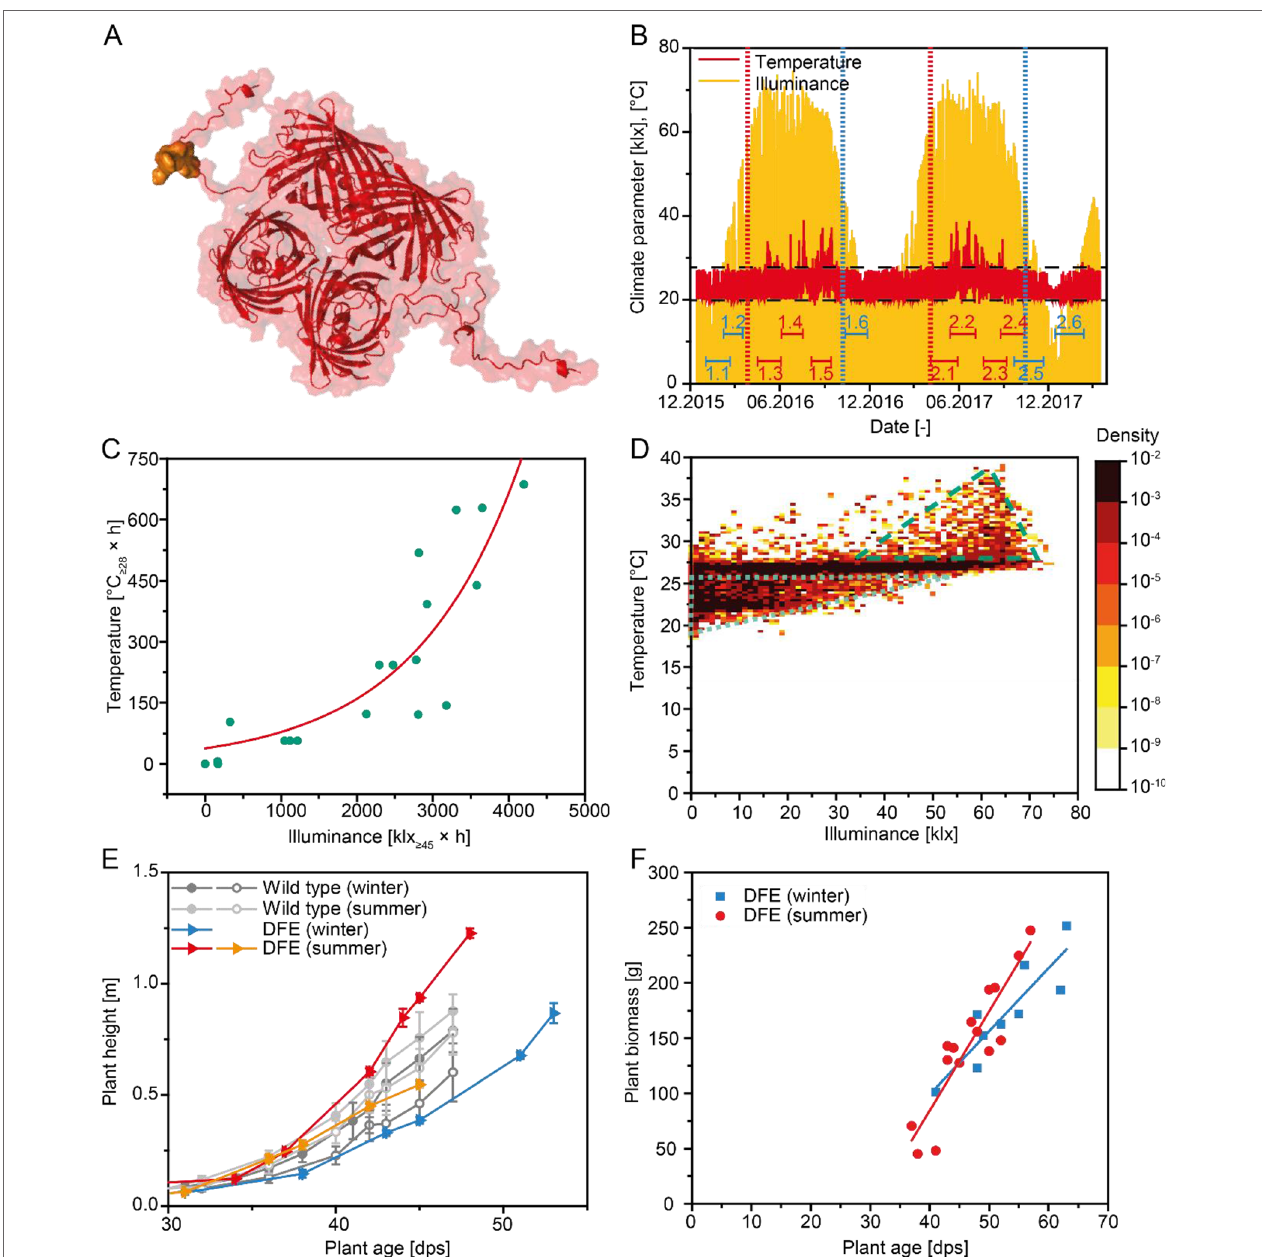
FIGURE 1 | Climate data and plant growth during the production of DFE. (A) Three-dimensional structure of a DFE tetramer. The DsRed part is shown in red, and the 2F5 epitope of the fusion part consisting of the 2F5 epitope, His 6 tag, and KDEL tag is highlighted in gold. (B) Temperature and illuminance data for the duration of this study. Batch durations are marked with double-T lines and numbers (blue = winter, red = summer). Vertical lines indicate the transition between seasons (blue = winter, red = summer). Dashed horizontal lines indicate temperature control limits. (C) Correlation between integrated temperature >28°C and integrated illuminance >45 klx approximated by a two-parameter exponential model. (D) Heat map of ~20,000 temperature–illuminance data points recorded with a frequency of one measurement per hour during 12 batches shown in (B) The dotted triangle marks data well within the temperature control range whereas the dashed triangle indicates a region with measurements outside the control limits. (E) Plant height according to plant age observed during cultivation in winter or summer for transgenic plants expressing DFE as well as wild-type controls. Error bars indicate the standard deviation (n ≥ 10); individual lines correspond different batches. (F) Average plant biomass at the time of harvest according to the age of transgenic plants expressing DFE. Six data points were obtained from a first set of six batches, whereas 18 data points were collected from a second set of six batches for which plants were harvested at three time points each. Lines indicate linear regression model on the data for winter (n = 9, r = 0.89) and summer (n = 15, r = 0.91)